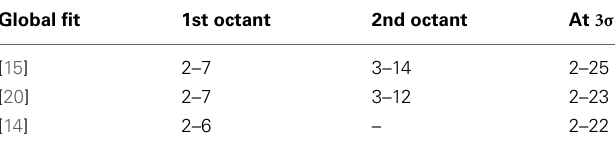
Table 1 | Allowed values of R ν oscillation fits.